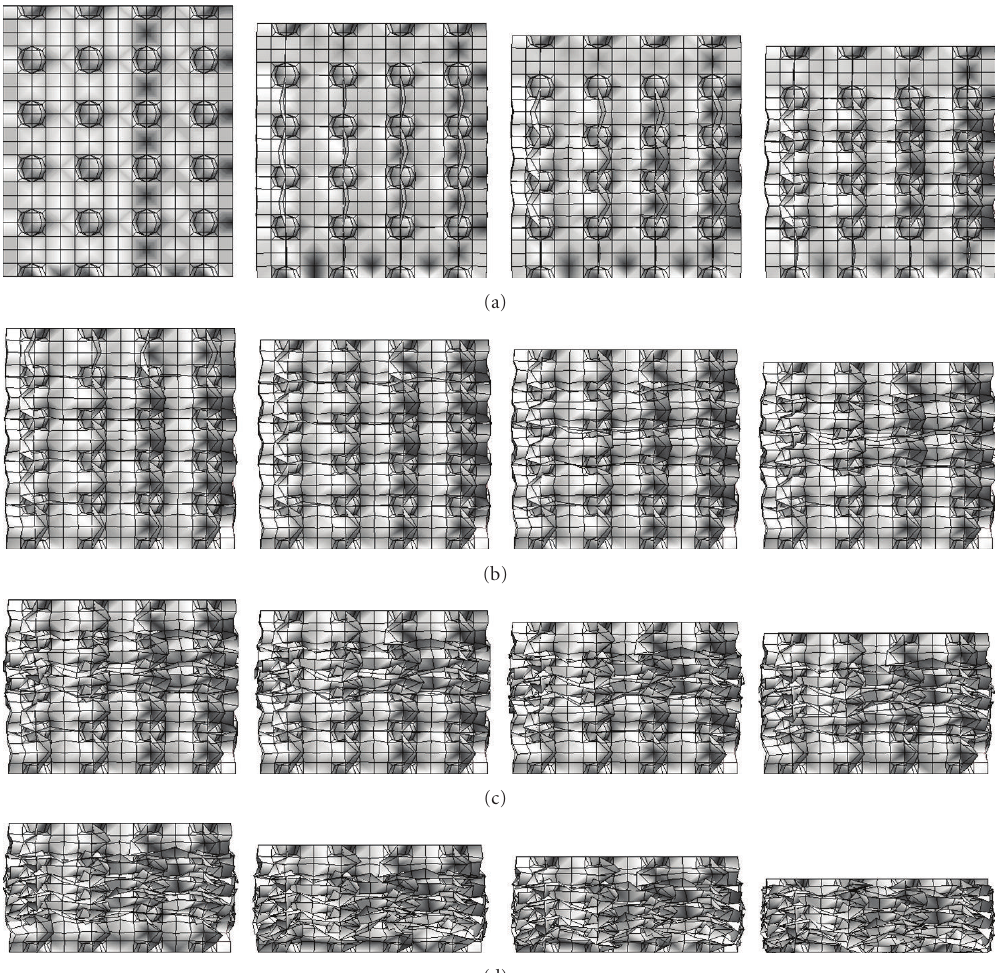
Figure 10: Two-dimensional views of the model in case of the deformation pattern-I: (simultaneous uniform deformation in all part of the foams) obtained from simulation using a uniform foam density.